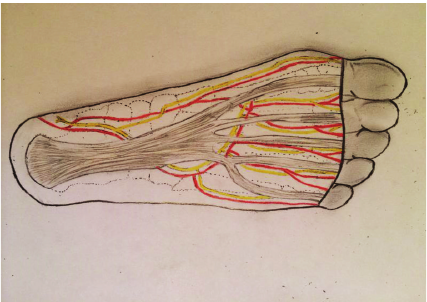
Figure 13: Schematic drawing of the anatomic relationship of the plantar fascia and the neurovascular structure of the foot’s sole.